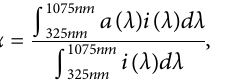
Frontiers in Earth Science |